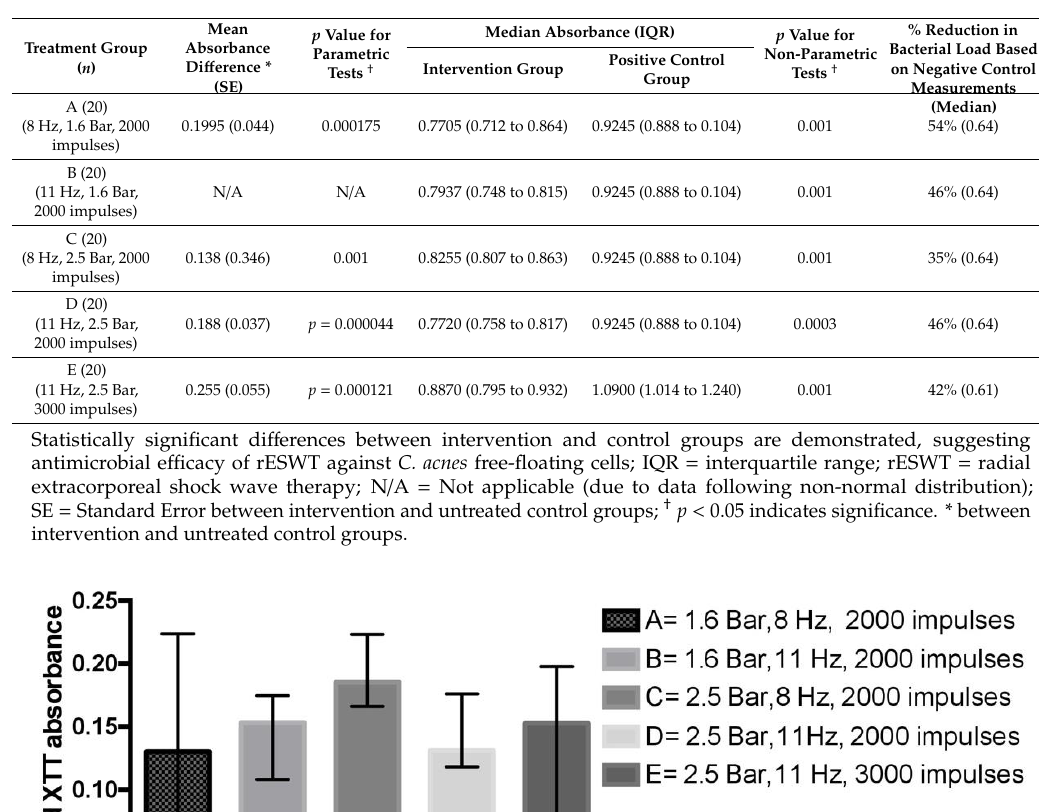
Table1. Antimicrobiale ff ectsofradialExtracorporealShockWaveTreatmenton C.acnes planktonicform.